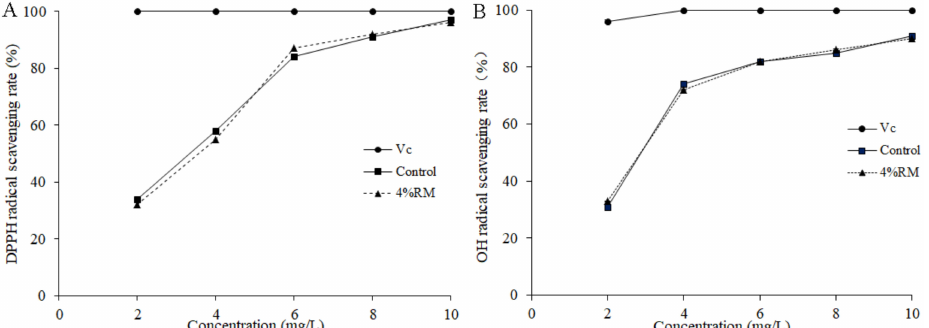
Figure 6. Antioxidant activity of polysaccharides extracted from the P. ostreatus mycelium. ( A ): hy- droxyl (OH) radical scavenging rate; ( B ): 2,2-diphenyl-1-picrylhydrazyl (DPPH) radical scavenging rate. Vc: vitamin